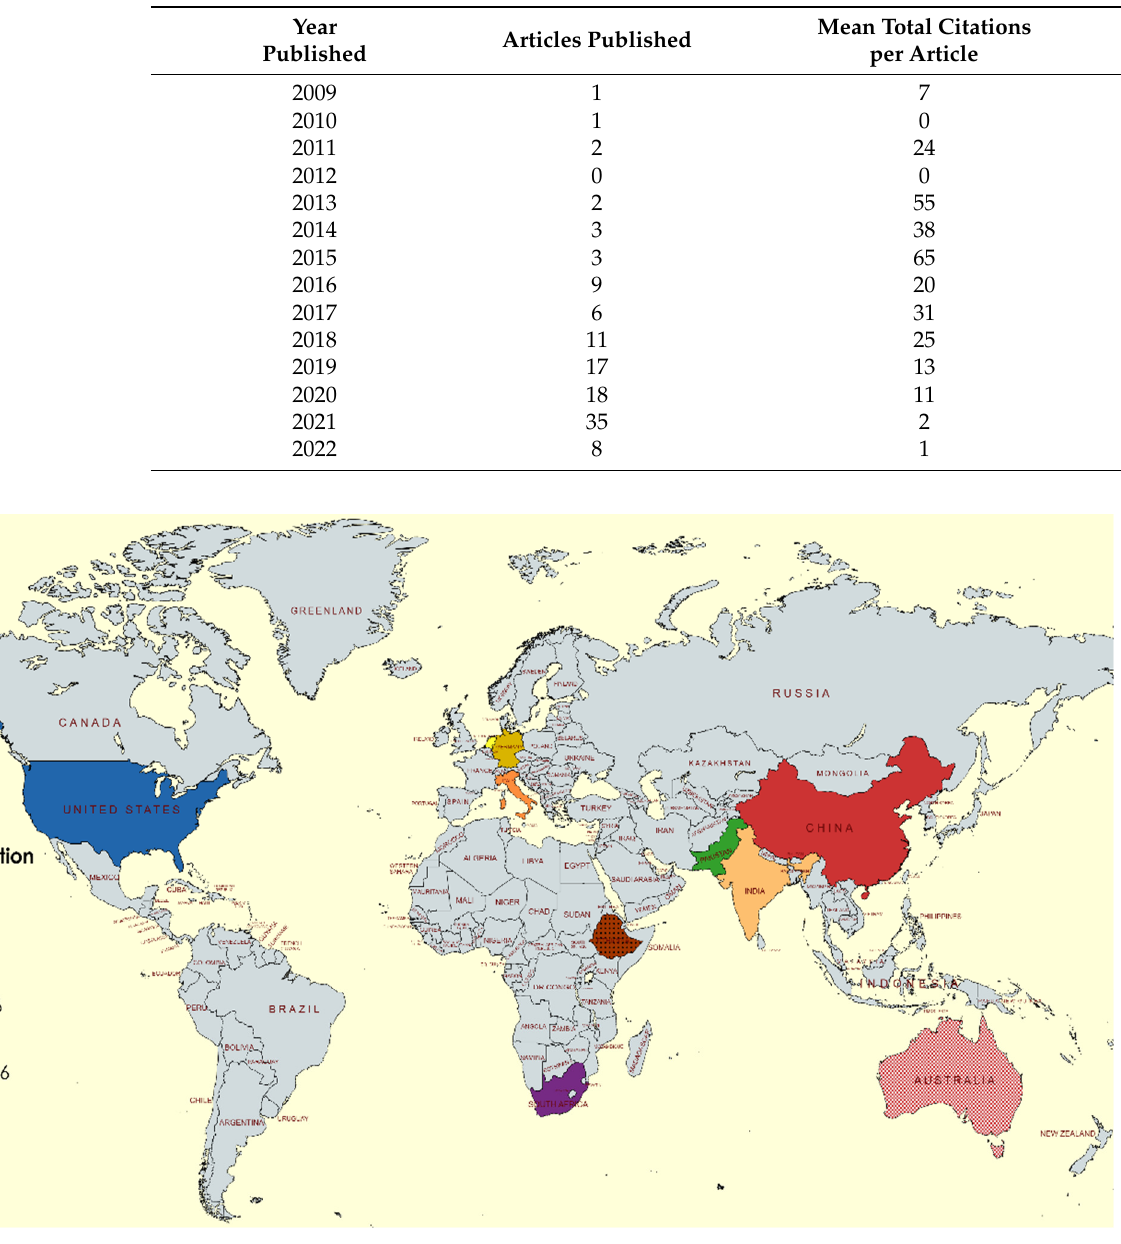
Figure 3. Top ten most active nations by corresponding authors within the period 2009–2022. Except for Germany, which has (5, 4%) published papers with SCP/MCP (2, 3), the other three nations have (4, 3%) published papers with SCP/MCP (2, 2) for Australia and Ethiopia, and SCP/MCP (1, 3) for Italy. The frequency of publication in the top nations ranges from 3 to 9. Table 6 shows that when the number of citations per nation measured productivity, India ranked first with n = 236 total cited articles. Sapkota [27] noted that climate change conditions, increases the cost of fuel, water shortage, and growing labor force, degradation in soil health, imbalanced and inadequate management of nutrients are some of the factors responsible for the stagnation of wheat production in the northwest of India. Italy, the United States, and Australia were mentioned more than a hundred times ( n = 122, 118, and 115), placing them second, third, and fourth, respectively. Similarly, the Netherlands, Kenya, Pakistan, Ethiopia, and Ireland were mentioned more than fifty times ( n = 94, 85, 69, 62, and 51). Except for the United Kingdom, which was mentioned fifty times, the other countries were Colombia, Nigeria, Germany, New Zealand, South Africa, China, Mexico, Canada, Cyprus, and Iran ( n = 48, 42, 40, 34, 33, 32, 25, 20, 12, and 11). This result is consistent with the findings of Li [41]. The level of intellectual endeavor, as assessed by citation count and publication activities, varies across the nation. The dis- persion of effort is unequal; gross national product or other metrics of productive capacity are roughly connected with activity levels. The top 20 articles sorted by total citations are displayed in Table 6, together with their digital object identification (DOI) numbers. Table 6. Top twenty most cited nations and top twenty most cited published papers within the period 2009–2022. Most Cited Nation